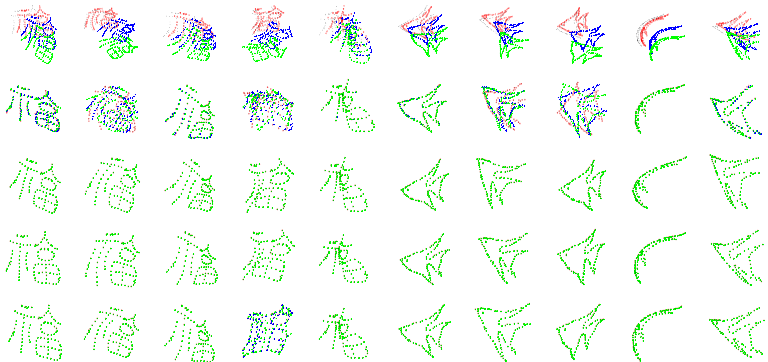
Figure 11. Registration results obtained from the application of group-wise rivals on the Chinese characters set and fish shapes for different level of degradation. Data with different levels of deformation (first row) and the corresponding obtained results by CDF-HC (second row), JRMPC (third row), TMM (fourth row), and Rényi’s (fifth